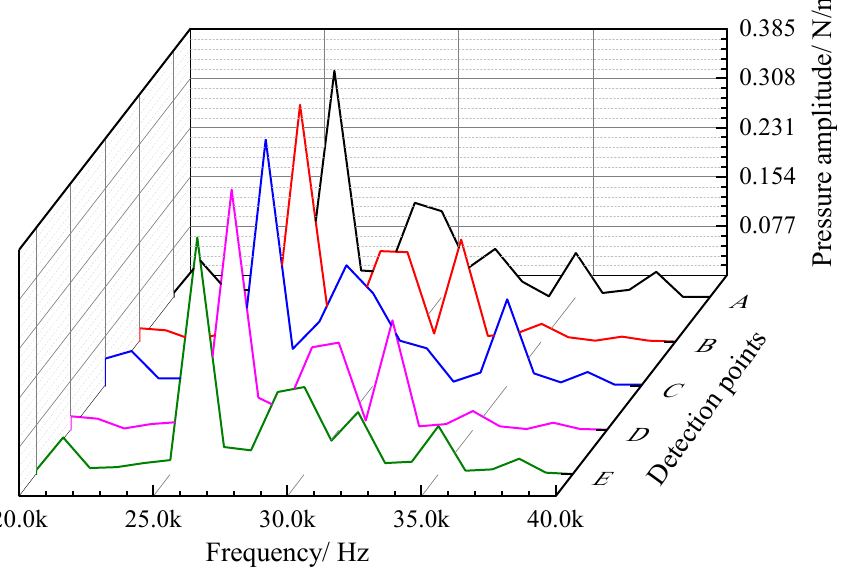
Figure 13. Sound pressure frequency spectrum curves of the five sampling points on the axis line of the oil pipe.